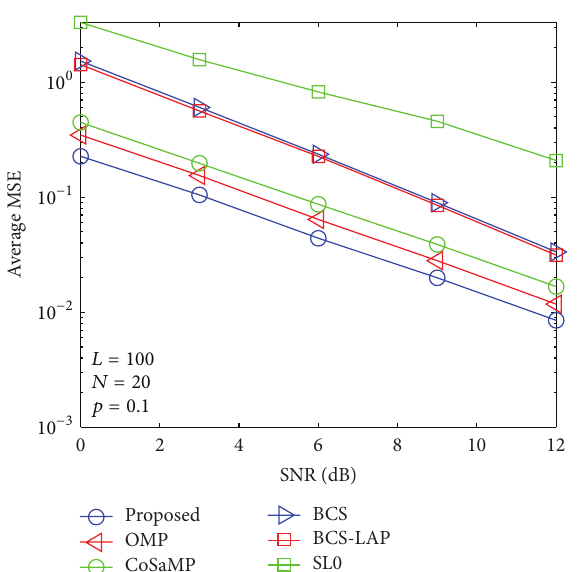
Figure 7: Average MSE performance versus SNR when 𝑝 1 = 0.1 and 𝑁 = 40